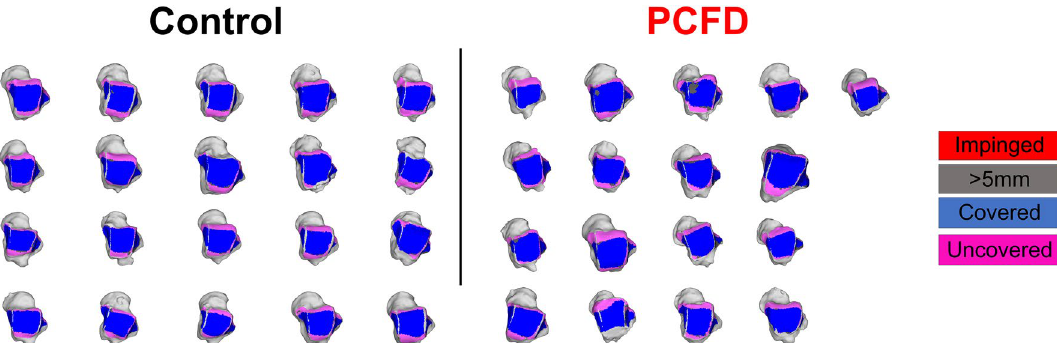
Figure 8. Tibiotalar joint colored Coverage Maps for all control and Progressive Collapsing Foot Deformity (PCFD) patients are presented. Tibia was removed and coverage maps are represented on the talar tome. Coverage Maps identify regions of impingement (red), normal joint interaction (Blue), articular uncoverage (Pink), and interactions greater than 5 mm (Dark